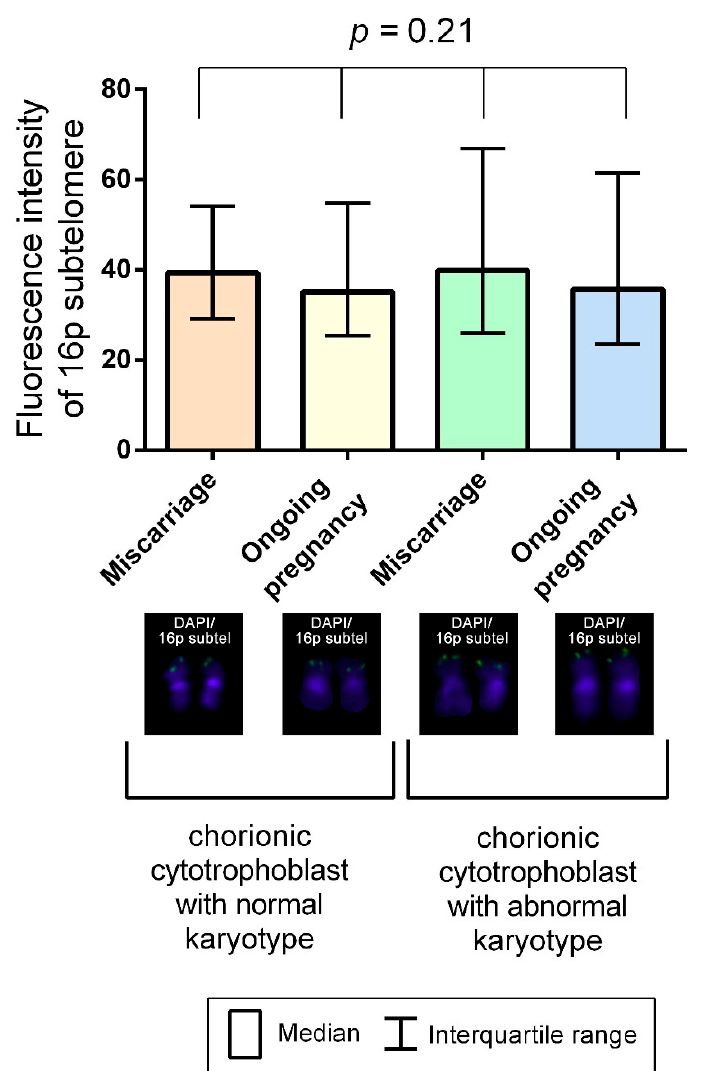
Figure 1. Column bar charts of 16p subtelomeric fluorescence intensity in the metaphase chromo- somes from chorionic cytotrophoblast cells in karyotypically normal and abnormal miscarriages and ongoing pregnancies. The Kruskal–Wallis test showed no significant difference among the groups ( p = 0.21).